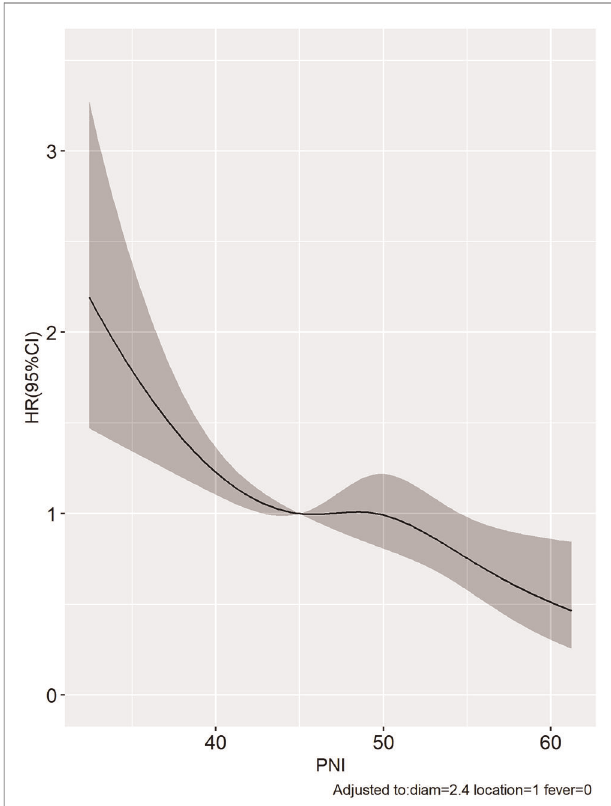
FIGURE 3 | The limited cubic spline showed that a signi fi cant negative correlation between PNI and OS in HCC patients within Milan criteria after US-PMWA.